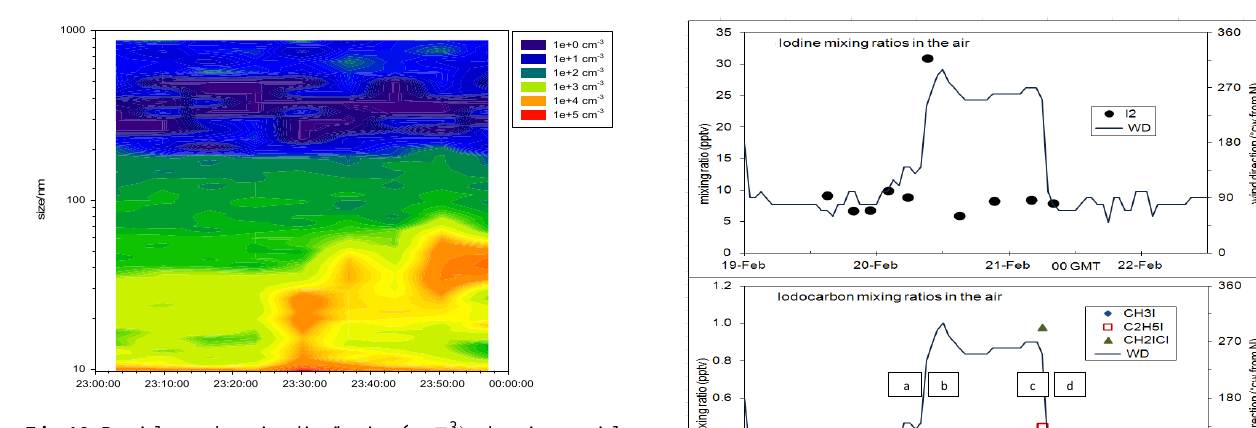
Fig. 9. Iodide, iodate and Chl a concentrations in the ice core of 13 March. Values have been normalised to brine volume and rationalised to salinity. Total iodine (iodide + iodate) and iodide / iodate ratios are also shown, except for the near-surface ratio where iodate was close to zero.